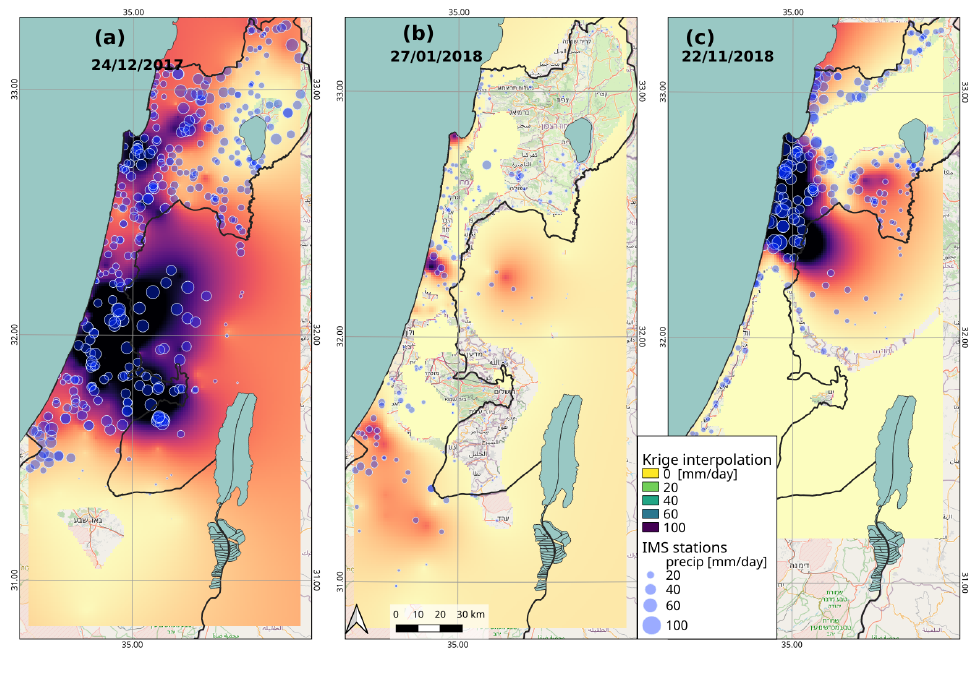
Figure 8. CML interpolated rainfall for three storm events. The interpolation method displayed is ordinary kriging. Gauge observed rainfall for the 24 h is overlaid as blue circles. Maps ( a – c ) show respectively the storm events for 24 December 2017, 27 January 2018, and 22 November 2018.